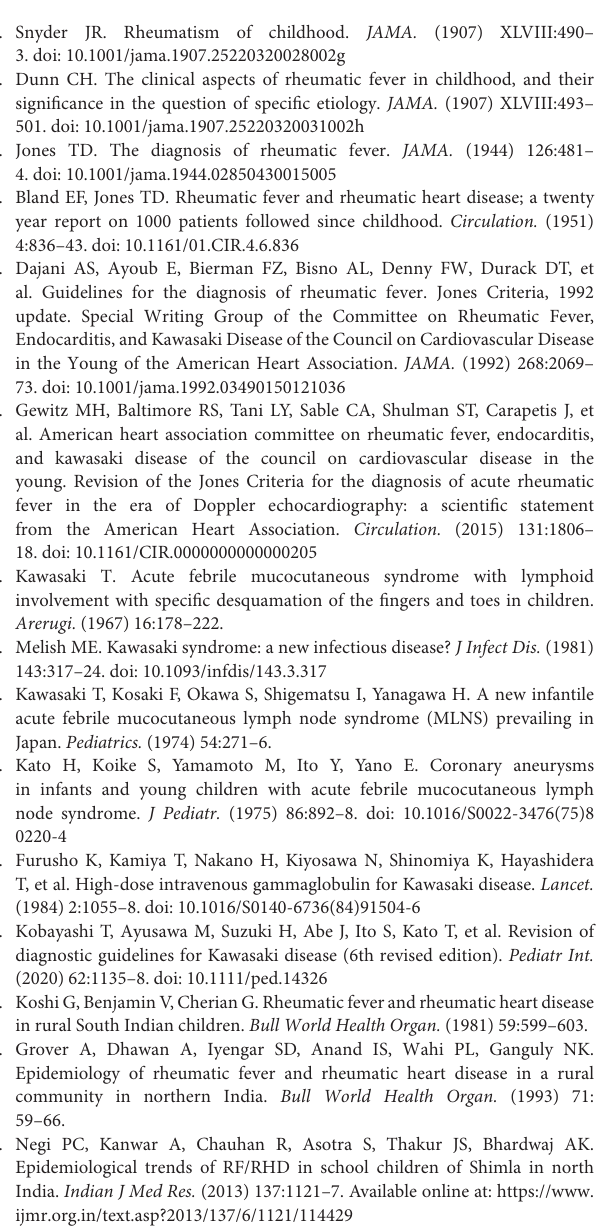
“high-risk” for acute rheumatic